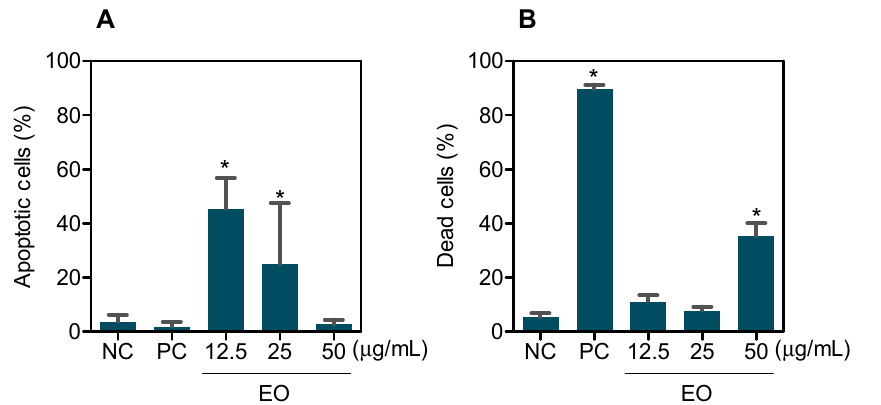
Figure 2. Effect of G. olivacea leaf EO on apoptosis induction in HepG2 cells after 48 h of treatment. ( A ) Quantification of apoptotic cells. ( B ) Quantification of dead cells (dead cells without identifying the type of cell death). Negative control ( NC ) was treated with vehicle (0.5% DMSO) used for diluting EO, and doxorubicin (0.5 µ g/mL) was used as positive control ( PC ). Data are presented as mean ± S.E.M. of at least three independent experiments. * p < 0.05 compared with negative control by ANOVA, followed by Student–Newman–Keuls test.